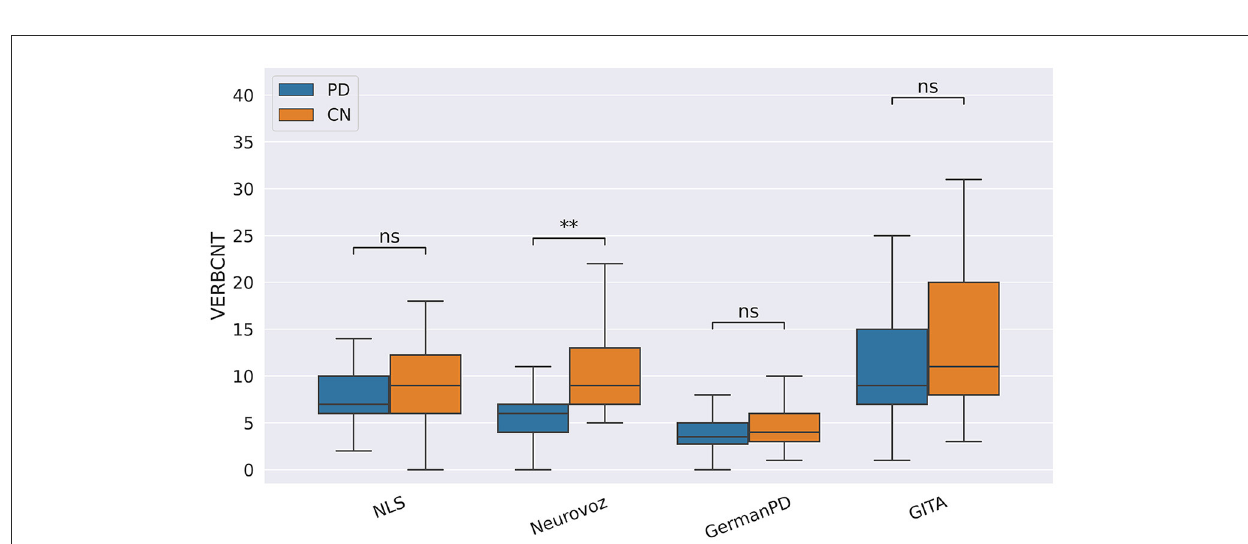
FIGURE6 Boxplots with statistical annotations representing the verb count (VERBCNT) on NLS, Neurovoz, GermanPD, and GITA from the SS task. Horizontal lines represent the median, the top ends represent the upper quartile, and the bottom ends represent the lower quartile. Statistically significant differences between groups after Benjamini–Hochberg correction for VERBCNT are reported in Table 6 and highlighted below using asterisks. VERBCNT, verb count; CN, control group; PD, Parkinson’s disease; SS, spontaneous speech; ns, not